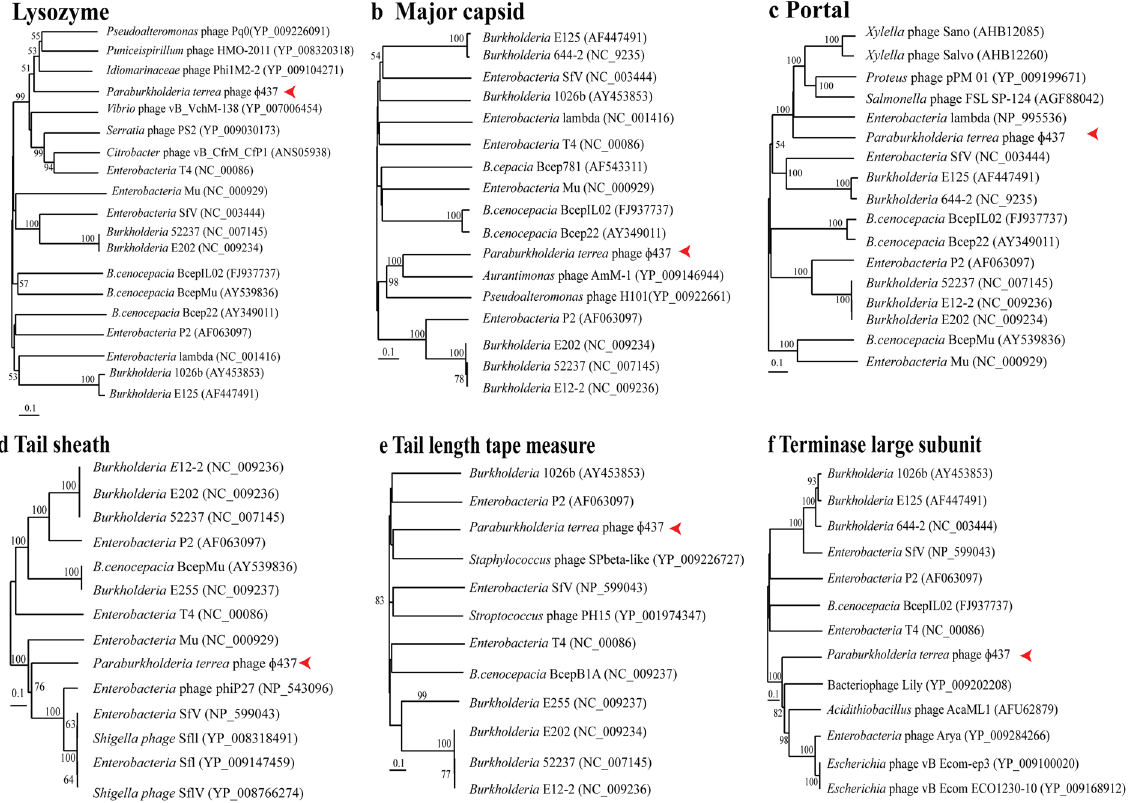
Figure 5. Phylogenetic trees of phage ɸ 437 for ( a ) lysozyme, ( b ) major capsid, ( c ) portal, ( d ) tail sheath, ( e ) tail length tape measure and ( f ) phage terminase large subunit. Phylogenetic tree were generated with neighbor- joining tree Mega version 7 with 1,000 boothstrap method and p -distance methods. Red arrows indicate ɸ 437. PSI-BLASTP best hits, coupled with other known Burkholderia phages were used in the